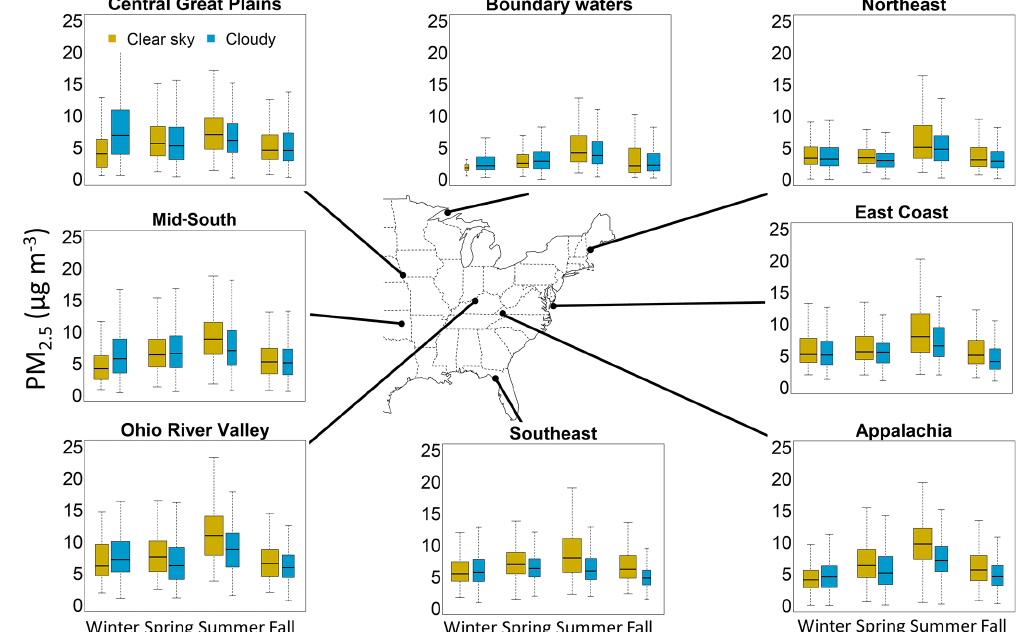
Figure 1. Differences in PM 2 . 5 mass concentrations in the eastern US. Clear-sky values are yellow and cloudy are blue. Median values are shown as a midline with box boundaries as the 75th and 25th percentiles. Whiskers are the 90th and 10th percentiles. Outliers are not shown but are included in calculations. PM 2 . 5 mass is typically highest during clear-sky conditions with the exception of winter.